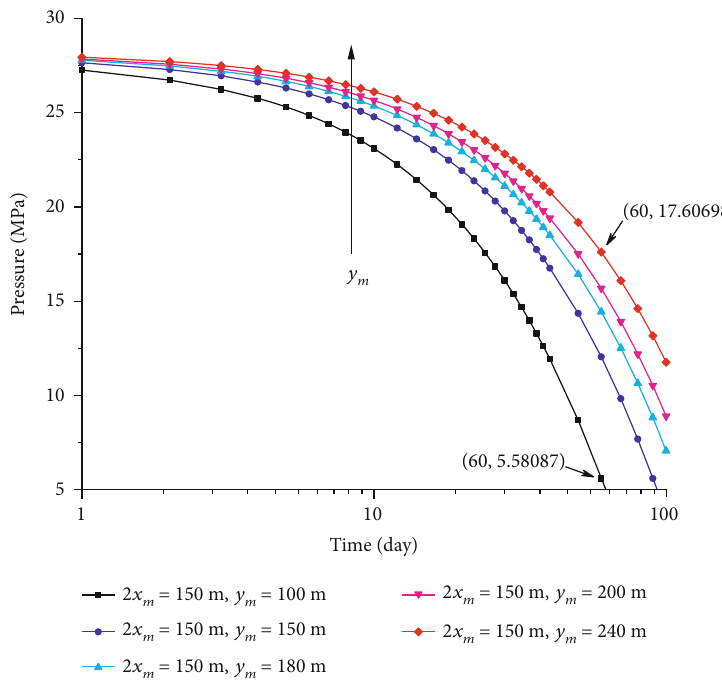
Figure 4: The e ff ect of SRV size on the curves (constant